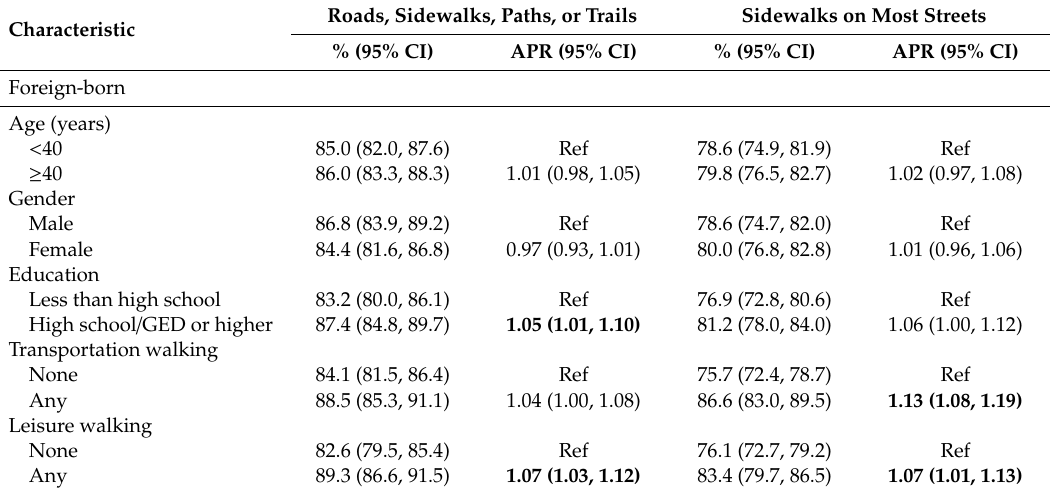
Figure 1. Interactions between nativity and age in relation to ( A ) perceived sidewalks on most streets (interaction p = 0.007) and ( B ) perceived bus or transit stops (interaction p = 0.01). Asterix indicates that the prevalence (95% CI) of the built environment attribute is significantly different by age for that nativity group. Table 3. Multivariate associations of socio-demographic characteristics and walking behaviors with perceived neighborhood transportation infrastructure among Latinos, stratified by nativity, the NHIS 2015.